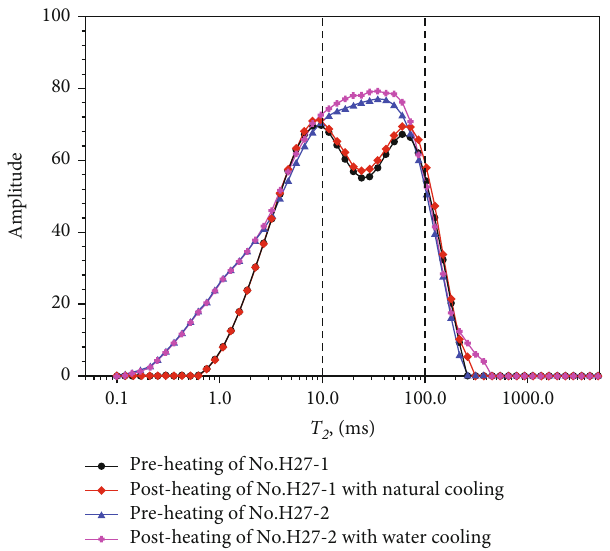
Figure 10: T spectrums and pore size distributions of the core 2 samples (No. H27-1 and No. H27-2) at 200 ° C under two di ff erent cooling methods.